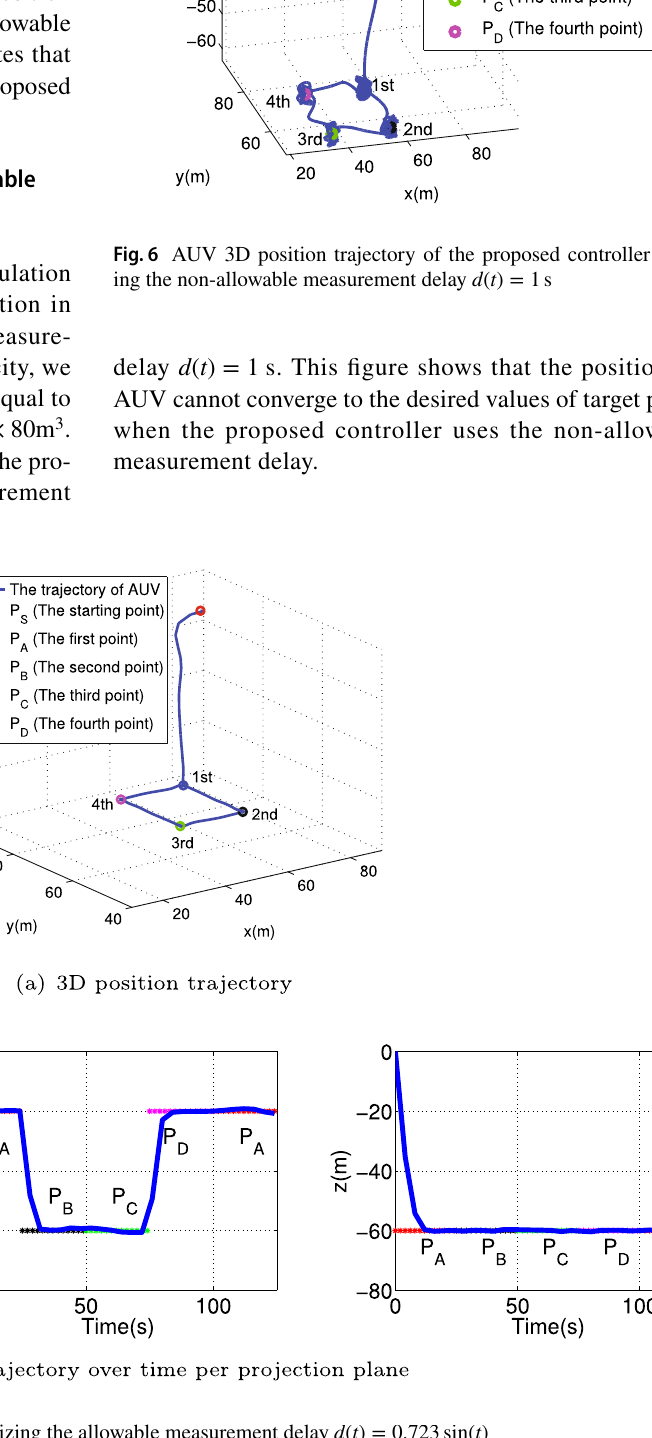
Fig. 5 AUV position trajectory of the proposed controller utilizing the allowable measurement delay d ( t ) = 0.723sin ( t )